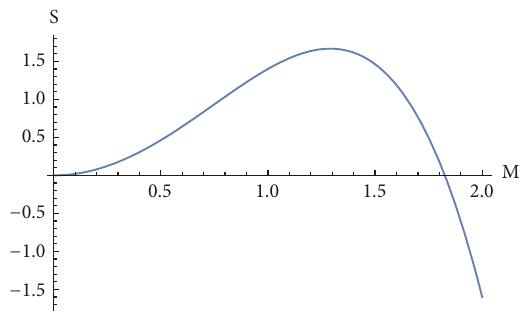
Figure 2: The entropy versus mass. The figure is plotted for 𝜆 = 0.1 and 𝑀 = 1